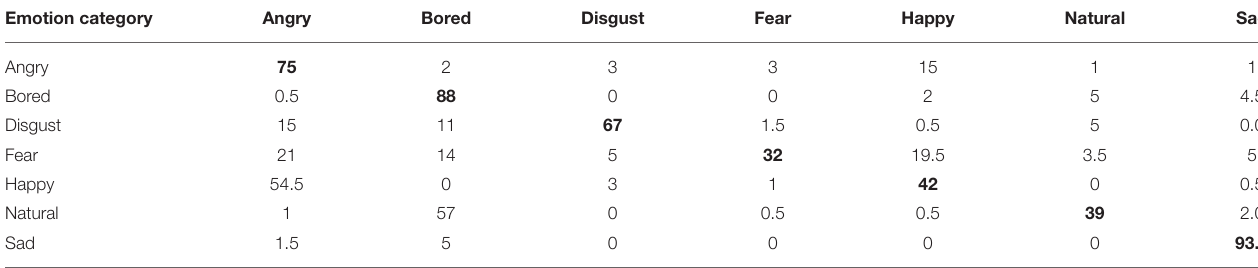
TABLE 3 | Recognition rate of traditional LSTM in Emo-DB. Emotion category